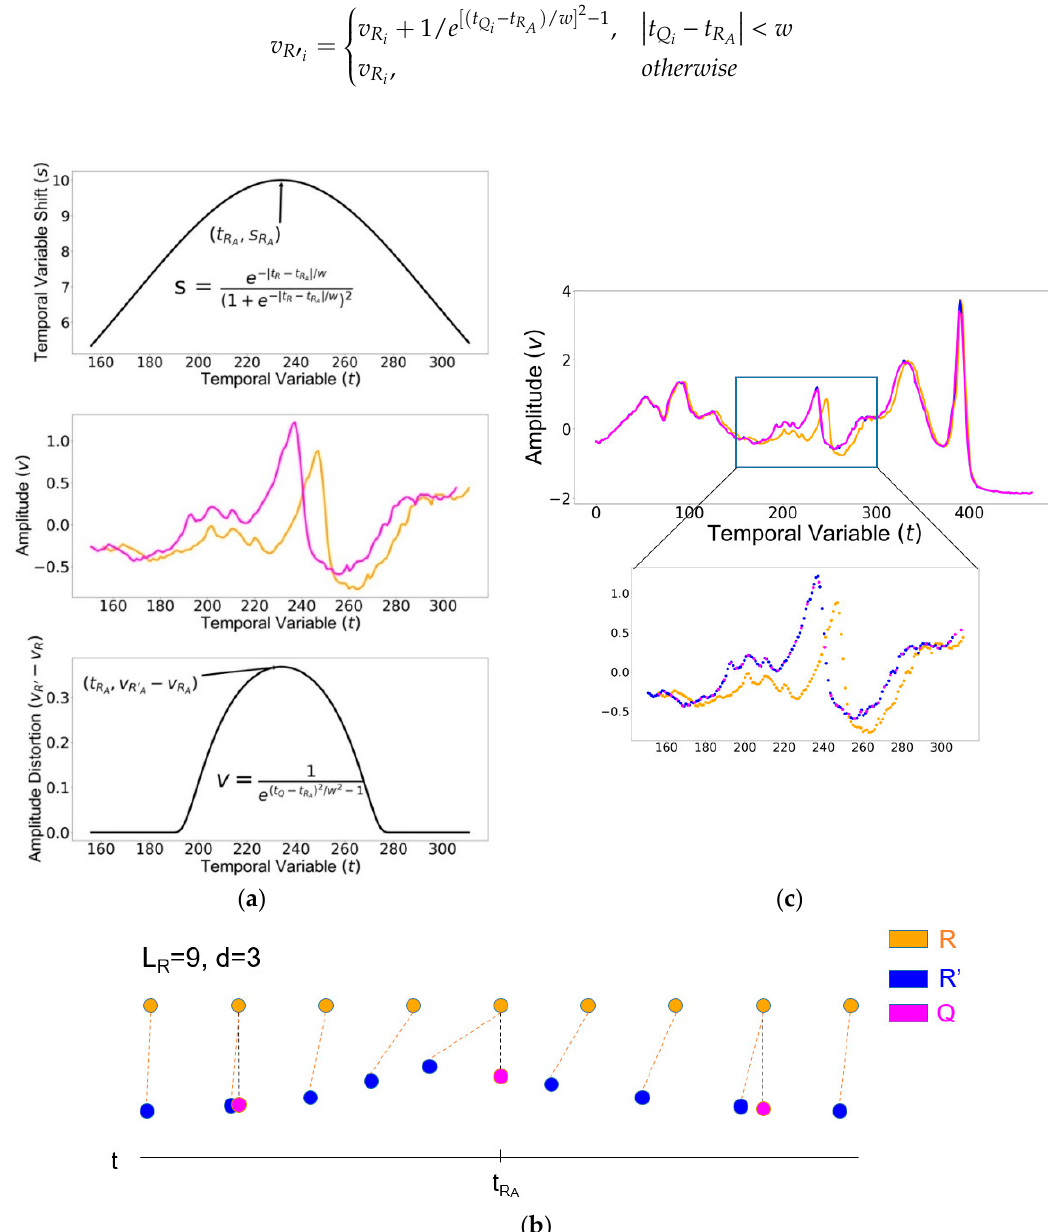
Figure 2. Figure 2. Generating the warped and down-sampled companion signal Q from the reference signal R : ( a ) The temporal variable shift and amplitude distortion of the exemplary signal; ( b ) a diagram of the companion signal generation process; ( c ) an example of the original signal R , the intermediate signal R (cid:48) , and the warped and down-sampled companion signal Q